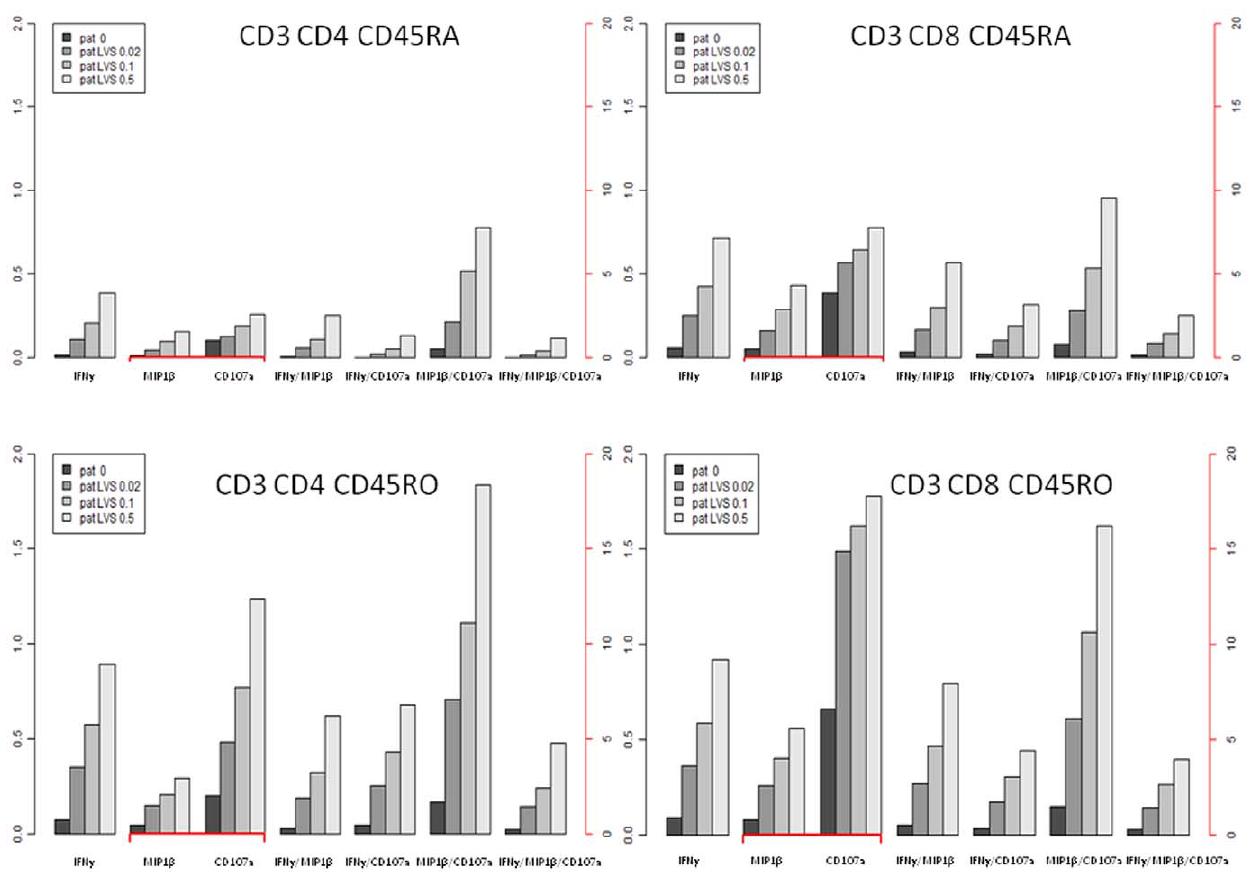
Figure 6. Histograms indicating the frequency of mono-, bi- and tri-functional cell subsets in CD45RO + and CD45RA + T-cell populations of convalescent patients. Mean values are illustrated throughout. The black axis indicates percentages for mono-functional IFN- c - positive and all bi- and tri-functional T-cell subsets. The red axis indicates percentages for MIP-1 b - and CD107a-positive mono-functional T cell subsets.